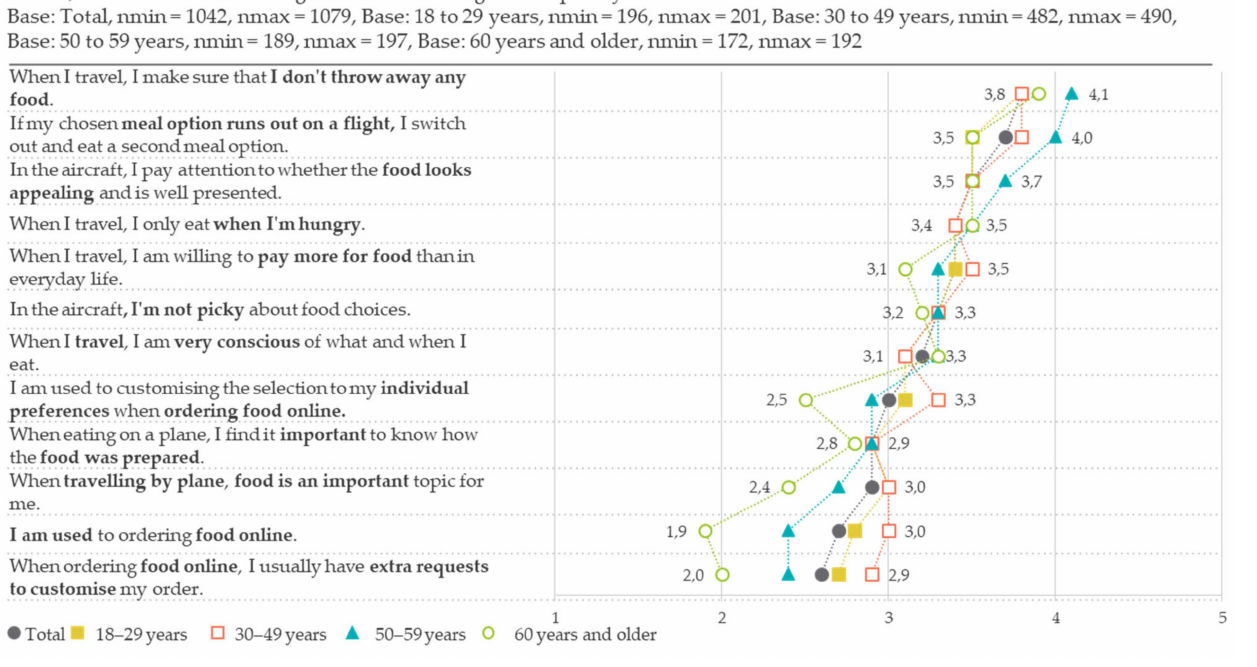
Figure 6. Statements on individuals’ eating behaviour (in Avg.) by age group. The interest in pre-ordering is higher among people who fly more frequently, as shown in Figure 7. For instance, individually selectable times at which the meal is served was more important for passengers who were frequent flyers.